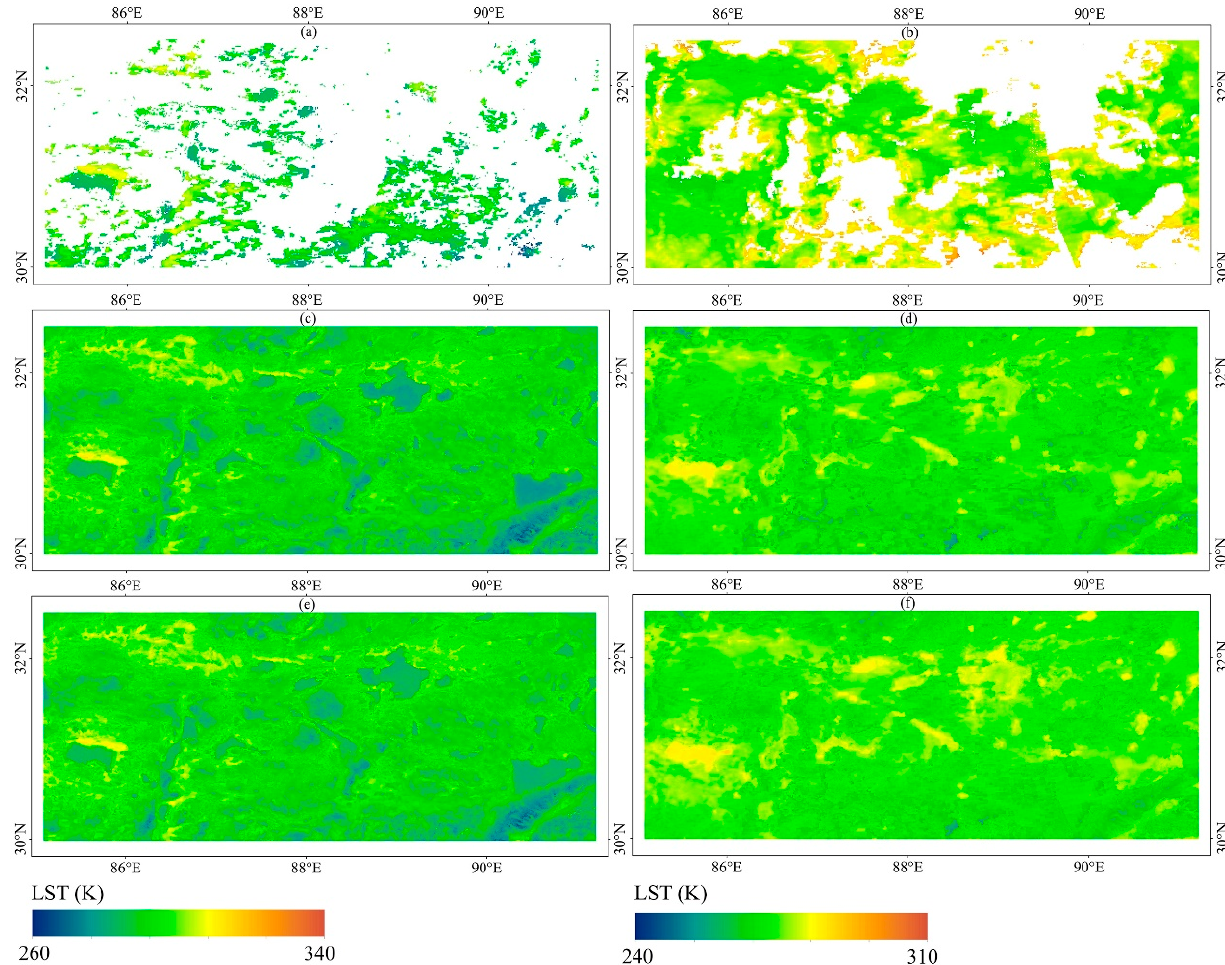
Figure 6. Comparison between ( a ) MODLSTD_Raw; ( b ) MODLSTN_Raw; ( c ) MODLSTD_Rec; ( d ) MODLSTN_Rec; ( e ) MODLSTD_SGRec, and ( f ) MODLSTN_SGRec on DOY 167 of 2018 for a subregion covered with water bodies.